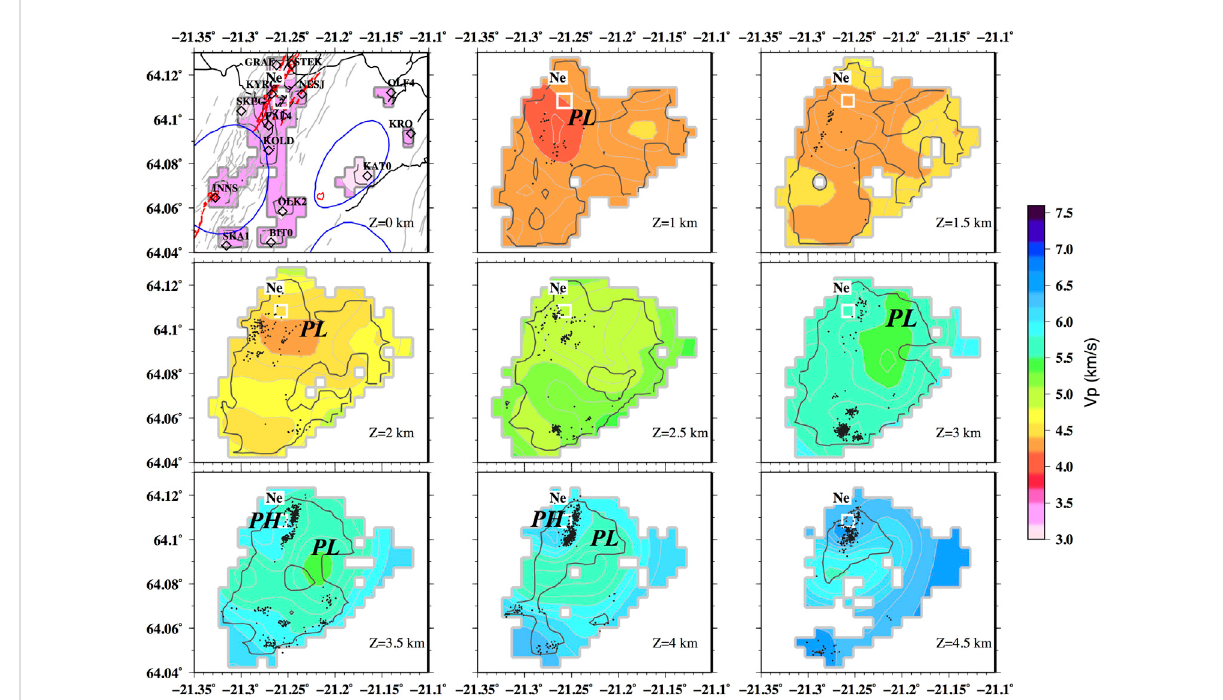
FIGURE 4 3D tomographic model: v P horizontal slices, depth below sea level. Black dots are earthquakes within 1 km around each slice from the 2,358 high quality events used for the tomography. The regions not covered by the ray paths are white. The dark gray contour line delimitates the well-resolvedareainferredbytheDerivativeWeightSum(DWS).Theuppermostslidetotheleft(z=0 km)showsfororientation,theseismicstations, roadsinblack, fi ssures,andcratersinred,fracturesingrayandbluelinesarethethreevolcaniccentersoftheregion.TheNesjavellirpowerplant is located in the white square, labeled Ne. PL is a low v P anomaly, PH is a high v P anomaly (discussed in Section